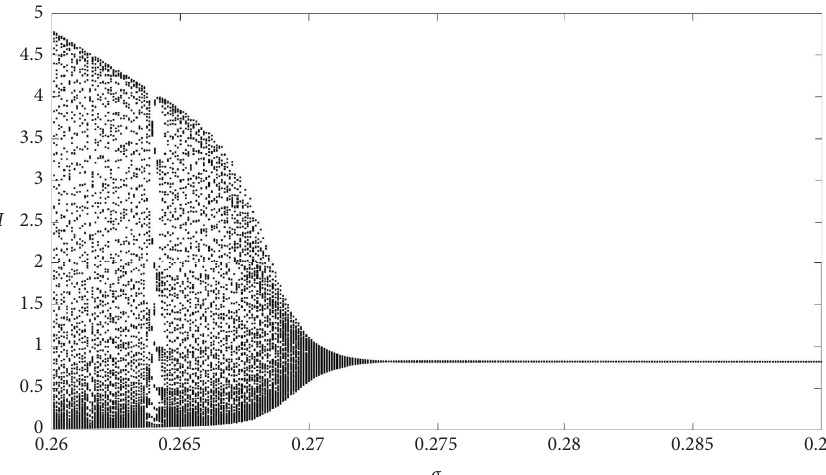
Figure 5: Te diagram of the Neimark-Sacker bifurcation, where R � 2 , k � 1 , c � 0 . 8 , σ ∗ � 0 . 278652 and the value of σ from 0.26 to 0.29.